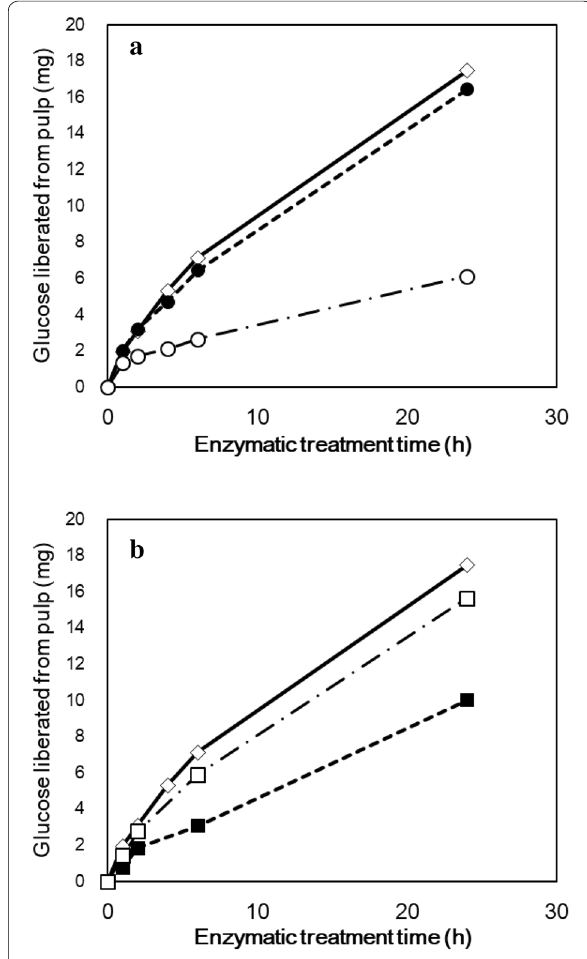
Fig. 1 The amount of glucose liberated from pulp by the enzymatic treatment with the enzyme dose 3.2 FPU/g: a larch pulp and b acacia pulp. open diamond: filter paper, open circle: soda–AQ pulp with the kappa number 56.6, open square: kraft pulp with the kappa number 22.8, and solid circle, solid square: SP with the kappa number 64.3 and 23.0, respectively. Enzymatic treatment: pulp 50 mg, acetate buffer pH 4.5 and 1.5 mL and temperature at 45 °C